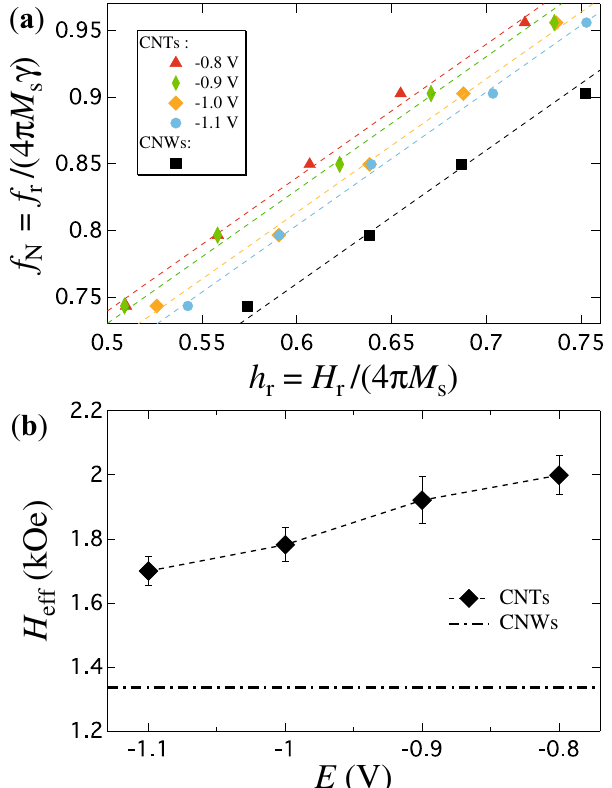
Figure 4. ( a ) Normalized dispersion relations, by the anisotropy field ( H F = 4 π M s ) and zero-field resonance frequency ( γ H F ) of a continuous thin Ni film, for Ni CNT networks with φ = 230 nm fabricated at reduction potentials in the range from − 0.8 V to − 1.1 V. ( b ) Variation of H eff as a function of the reduction potential (lozenges) for Ni CNT networks along with the value for a Ni CNW network (dash-dotted line). Error bars are estimated from the standard deviation of the experimental f N vs h r dispersion